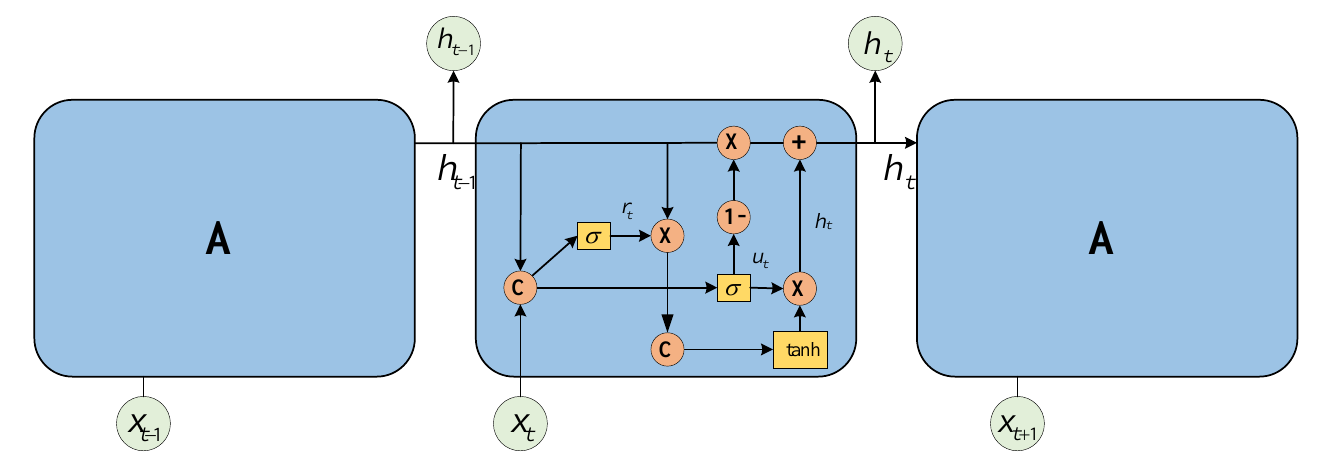
Figure 11. GRU model internal structure.